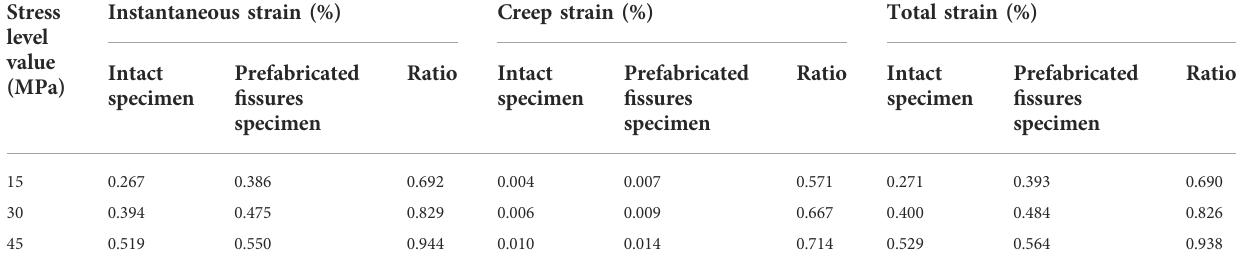
TABLE 1 The instantaneous strain, creep strain, and total strain of specimens under the same stress level. Stress